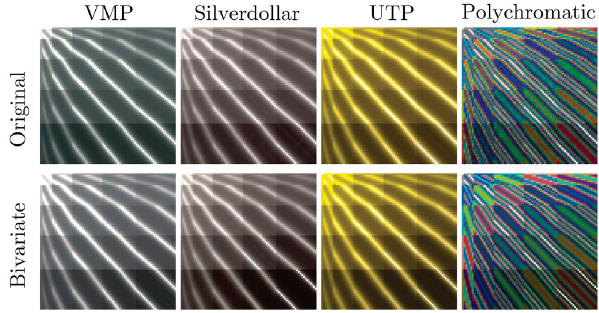
Fig. 5 BRDFs captured using hemispherically uniform sampling of 81 viewing (horizontal axis) and illumination (vertical axis) directions (total 6561 samples) [44] compared to BRDFs interpolated from the captured bivariate isotropic representation (Δ θ h / Δ θ d = 5 ◦ / 15 ◦ ).